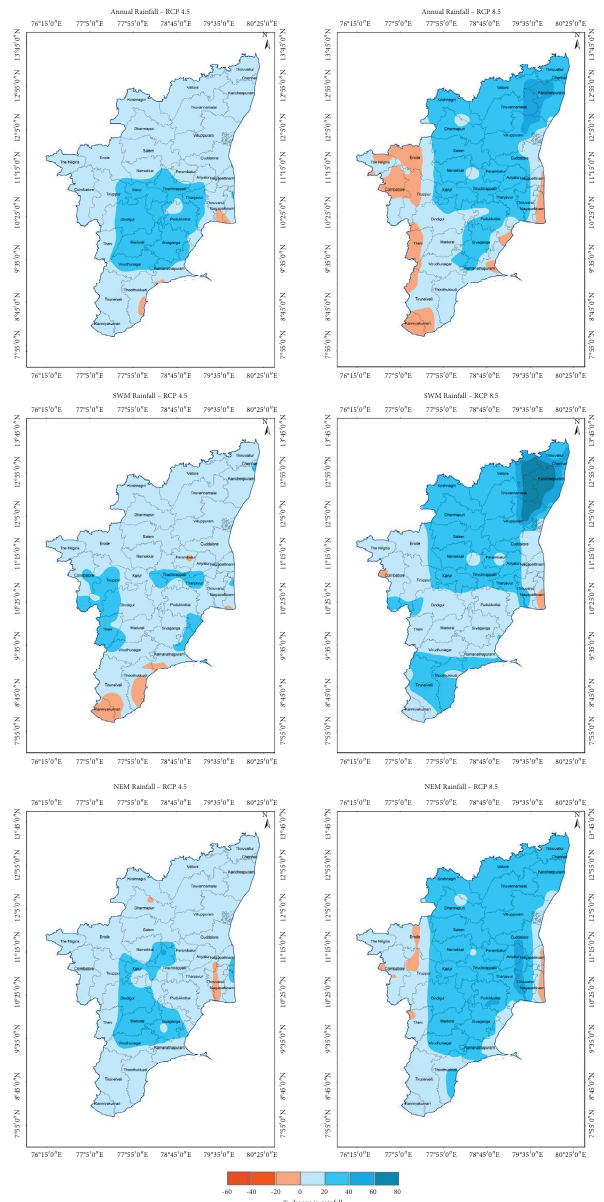
Figure 4: Multi-climate model ensemble projection of rainfall deviation (%) for RCP 4.5 and RCP 8.5 over baseline.